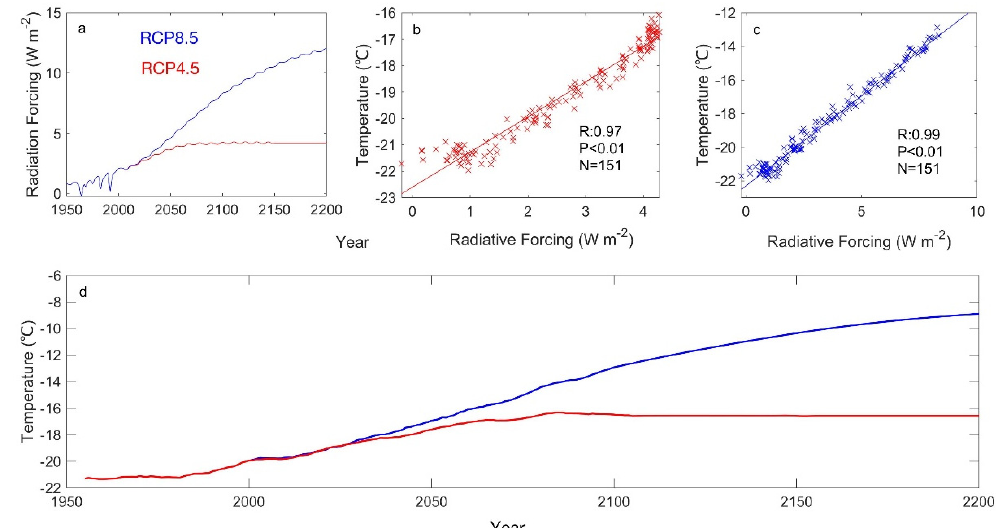
Figure 3. ( a ) Annual global radiative forcing under RCP4.5 (red) and RCP8.5 (blue) scenarios. ( b , c ) GrIS near-surface air temperature as a function of global radiative forcing under RCP4.5 ( b ) and RCP8.5 ( c ) from 1950 to 2100. ( d ) Decadal GrIS temperature change calculated by 5 downscaled ESMs (1950–2100; Table 1) and global radiative forcing (2101–2200) under historical (red, 1950–2005), RCP4.5 (red, 2006–2200), and RCP8.5 (blue, 2006–2200) scenarios.